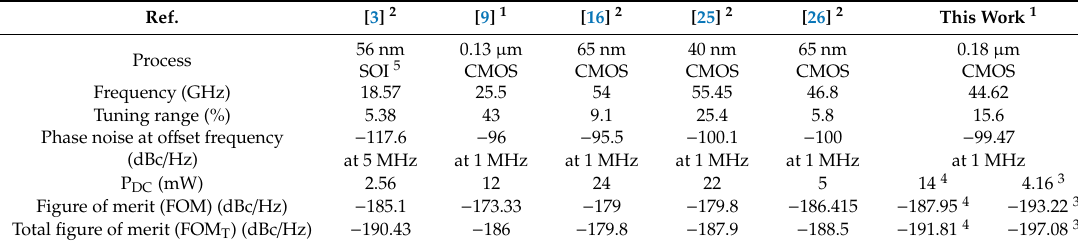
Figure of merit (FOM) (dBc / Hz) Total figure of merit (FOM T ) (dBc / Hz) 1 Simulation result; 2 Measurement result; 3 Including the power consumption of the VCO; 4 Including the power consumption of the total structure; 5 Silicon on